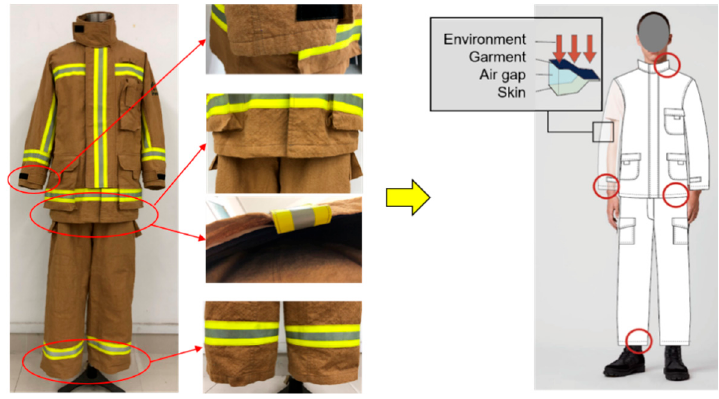
Figure 3. Garment aperture structures and the relationship of garment, air gap and skin.